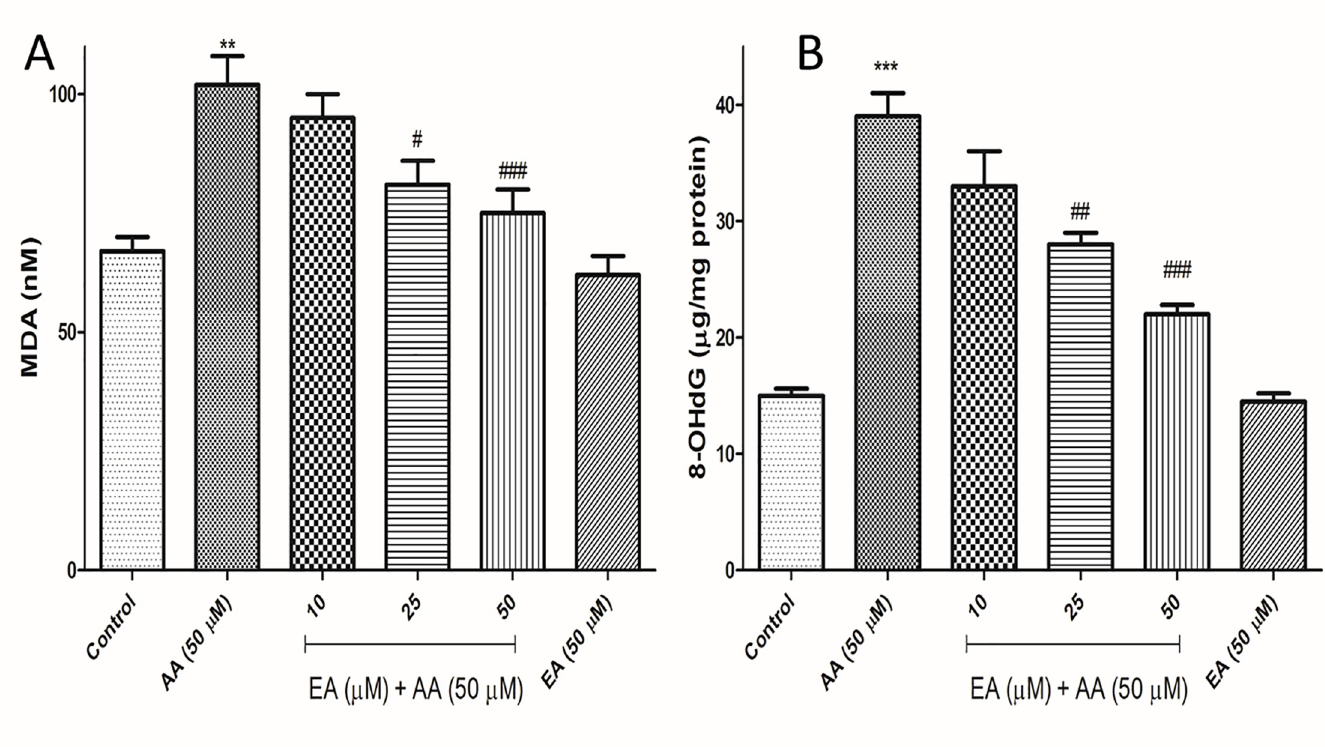
Fig 6. Addition of ellagic acid decreases AA-induced lipid peroxidation (A) and DNA oxidation (B) in human lymphocytes. (A) Representative measurements of lipid peroxidation following AA exposure (4 h) in the presence or absence of EA in human lymphocytes. Graph B presents measurements of DNA oxidation using kite following AA exposure (4 h) in the presence or absence of EA in human lymphocytes. Results are shown as mean ± SD, n = 3 technical replicates. All experiments were repeated at least three times. ��� p < 0.001: Control versus AA; #p < 0.05, ###p < 0.01, ###p < 0.001: AA + EA versus AA-treated human lymphocytes ANOVA, Tukey’s